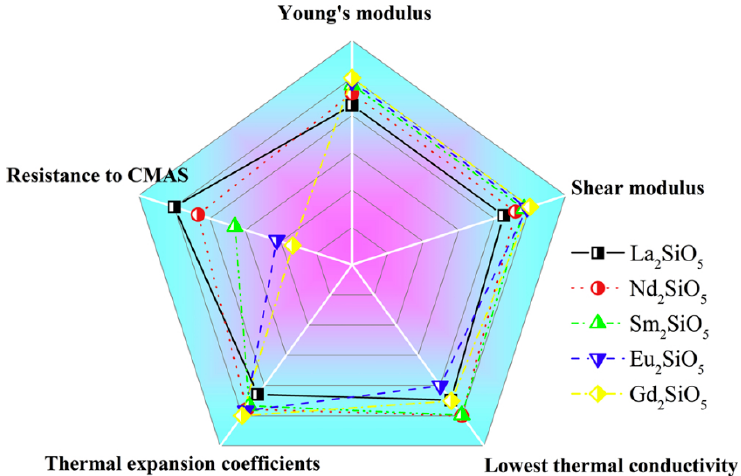
Figure 8. Spider chart for a comparison of the properties of X1-RE 2 SiO 5 [138].